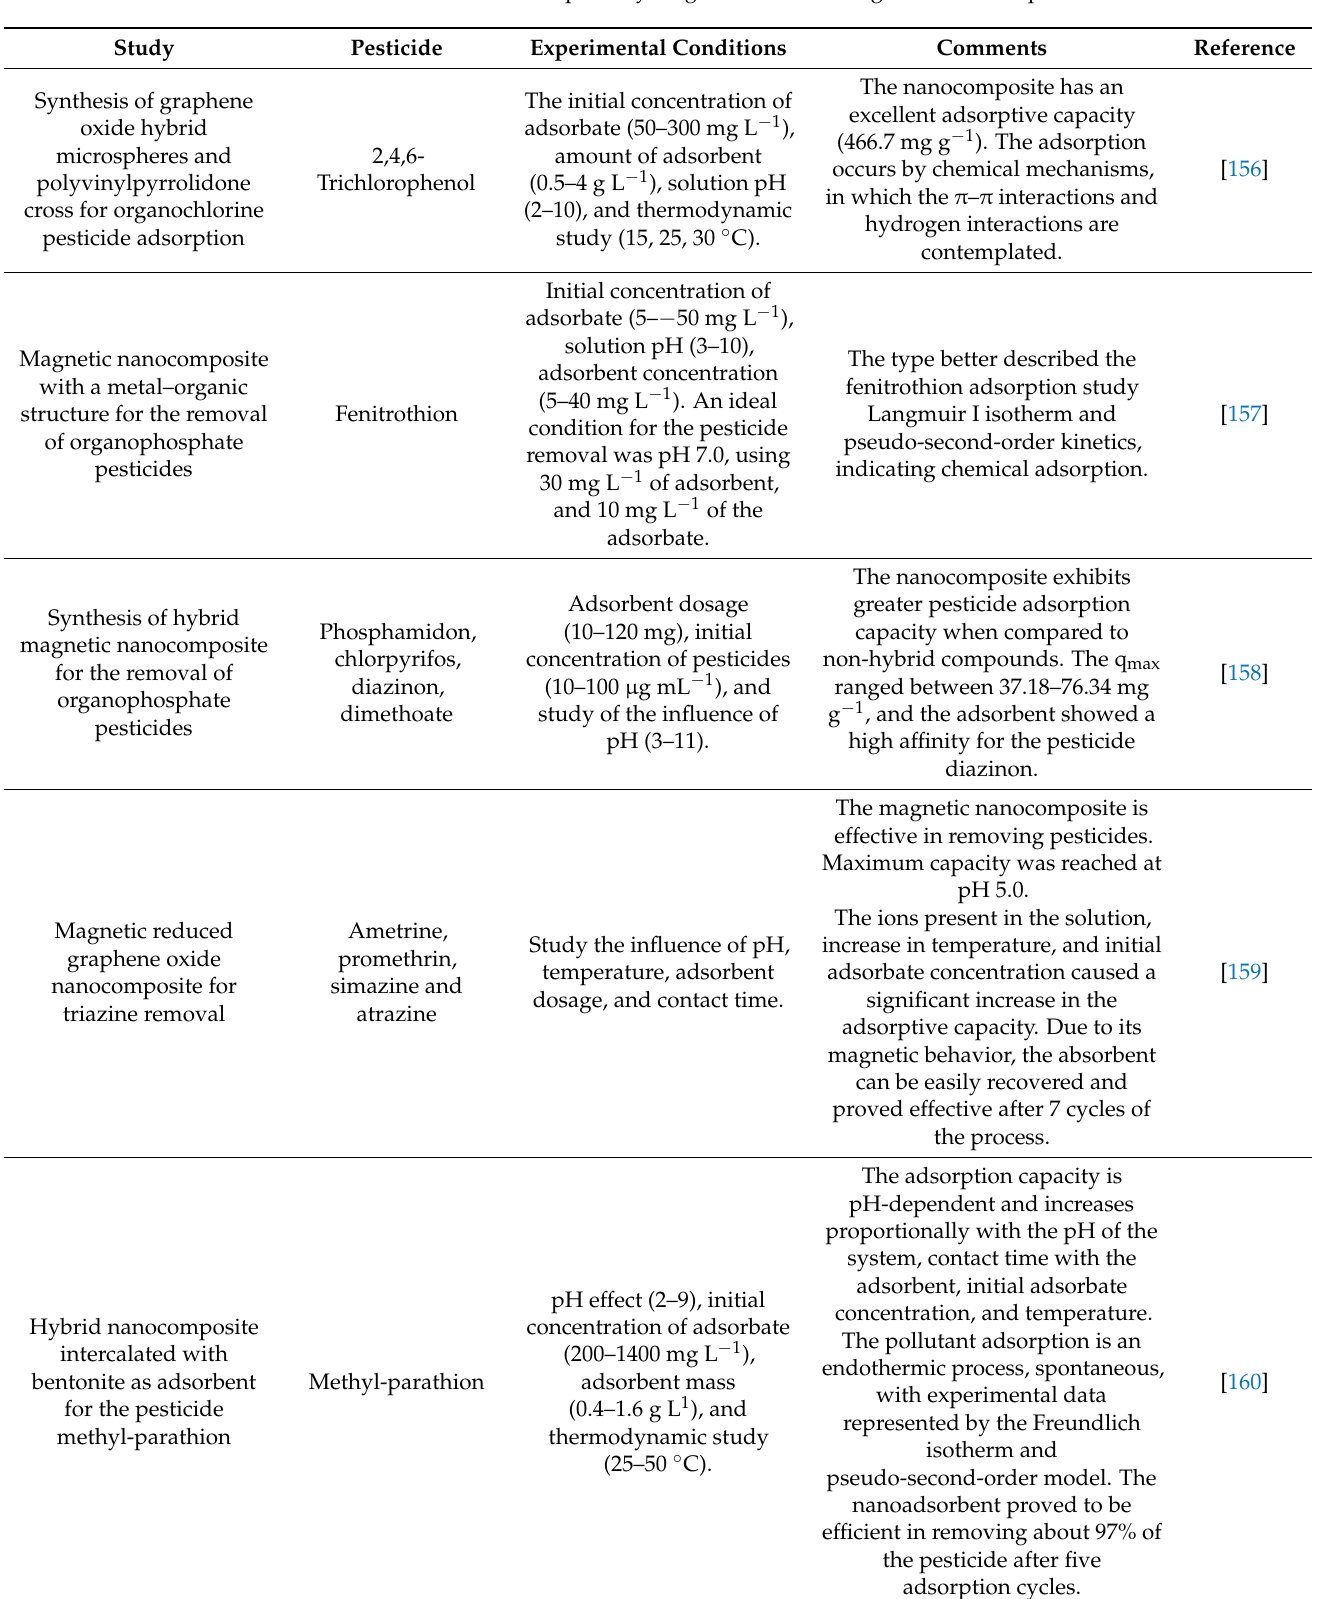
Table 3. Pesticide adsorption by magnetic and non-magnetic